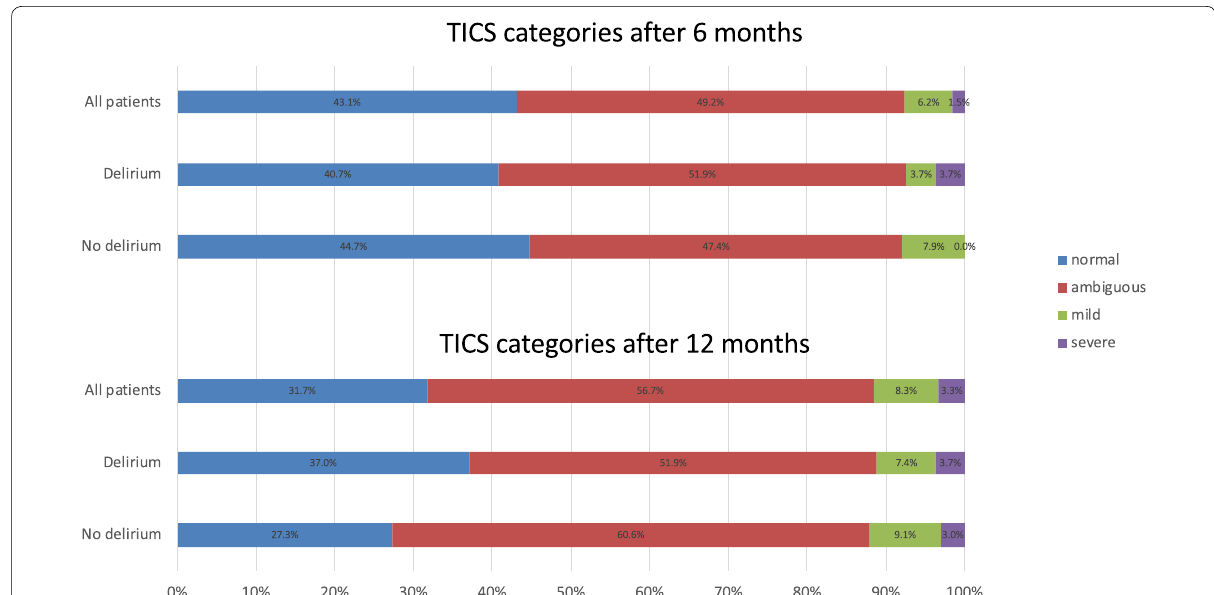
Fig. 3 Frequency distribution of TICS categories after 6 and 12 months in all patients, and in patients with and without delirium during ICU stay